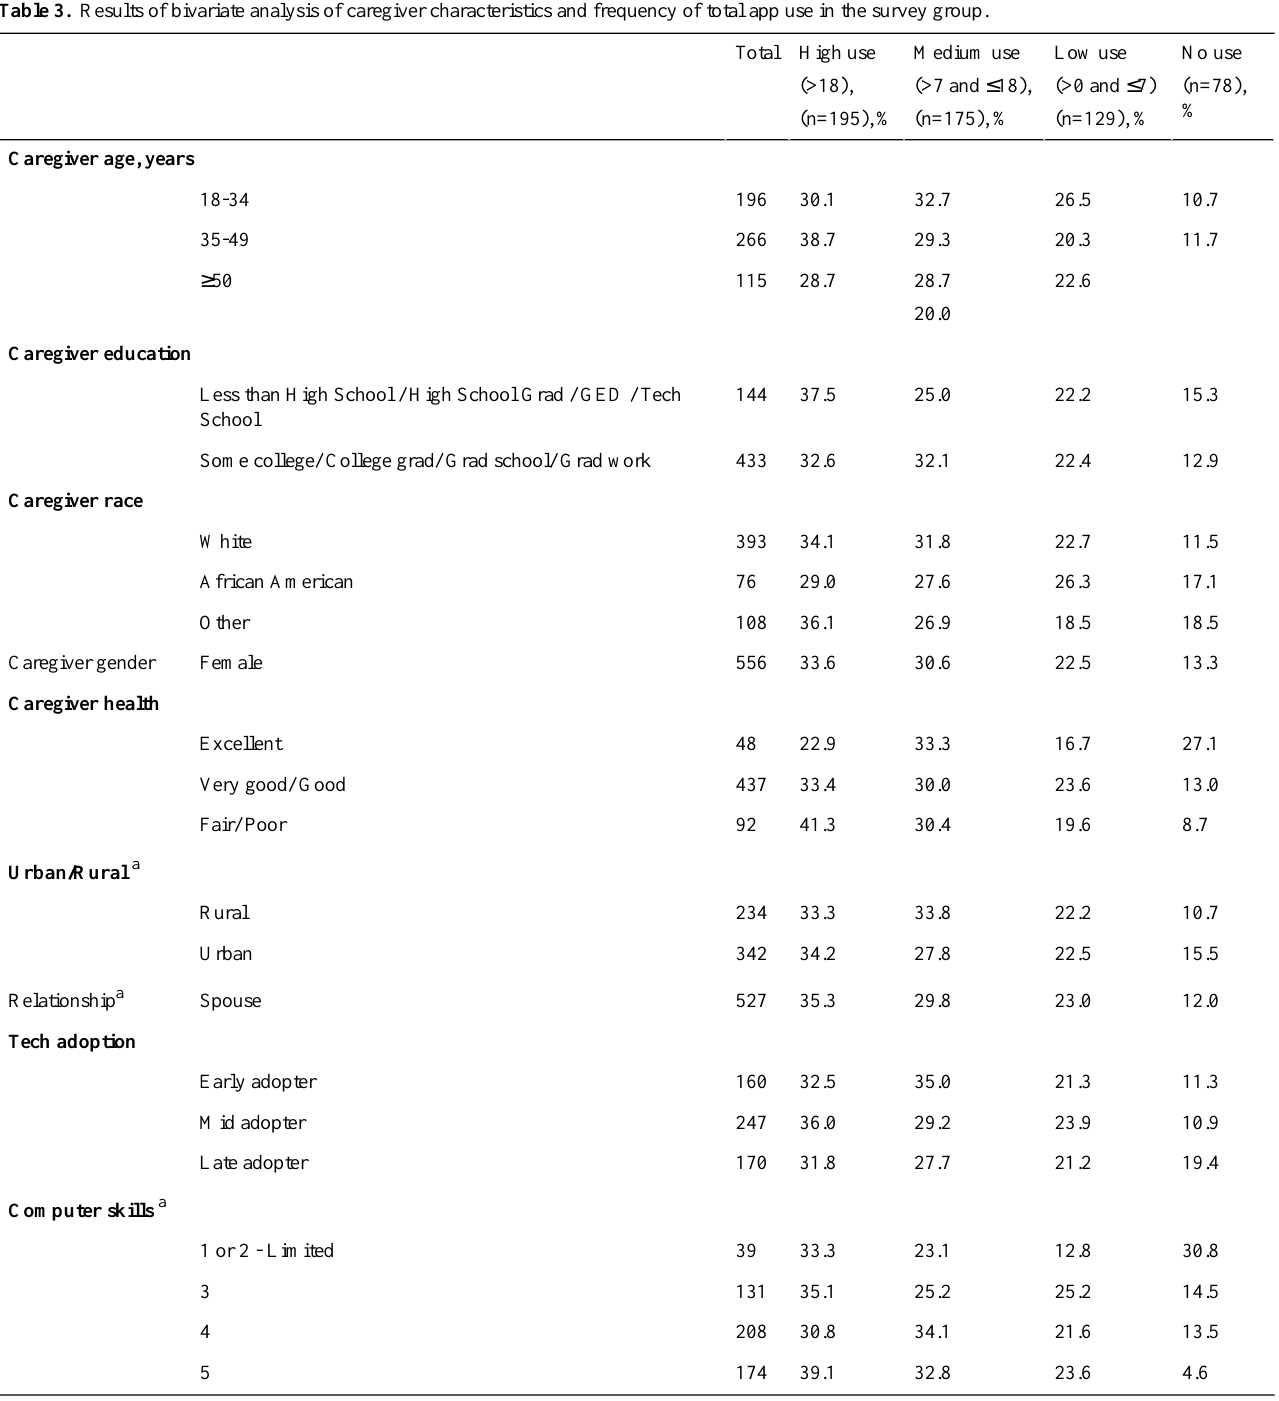
Table 3. Results of bivariate analysis of caregiver characteristics and frequency of total app use in the survey